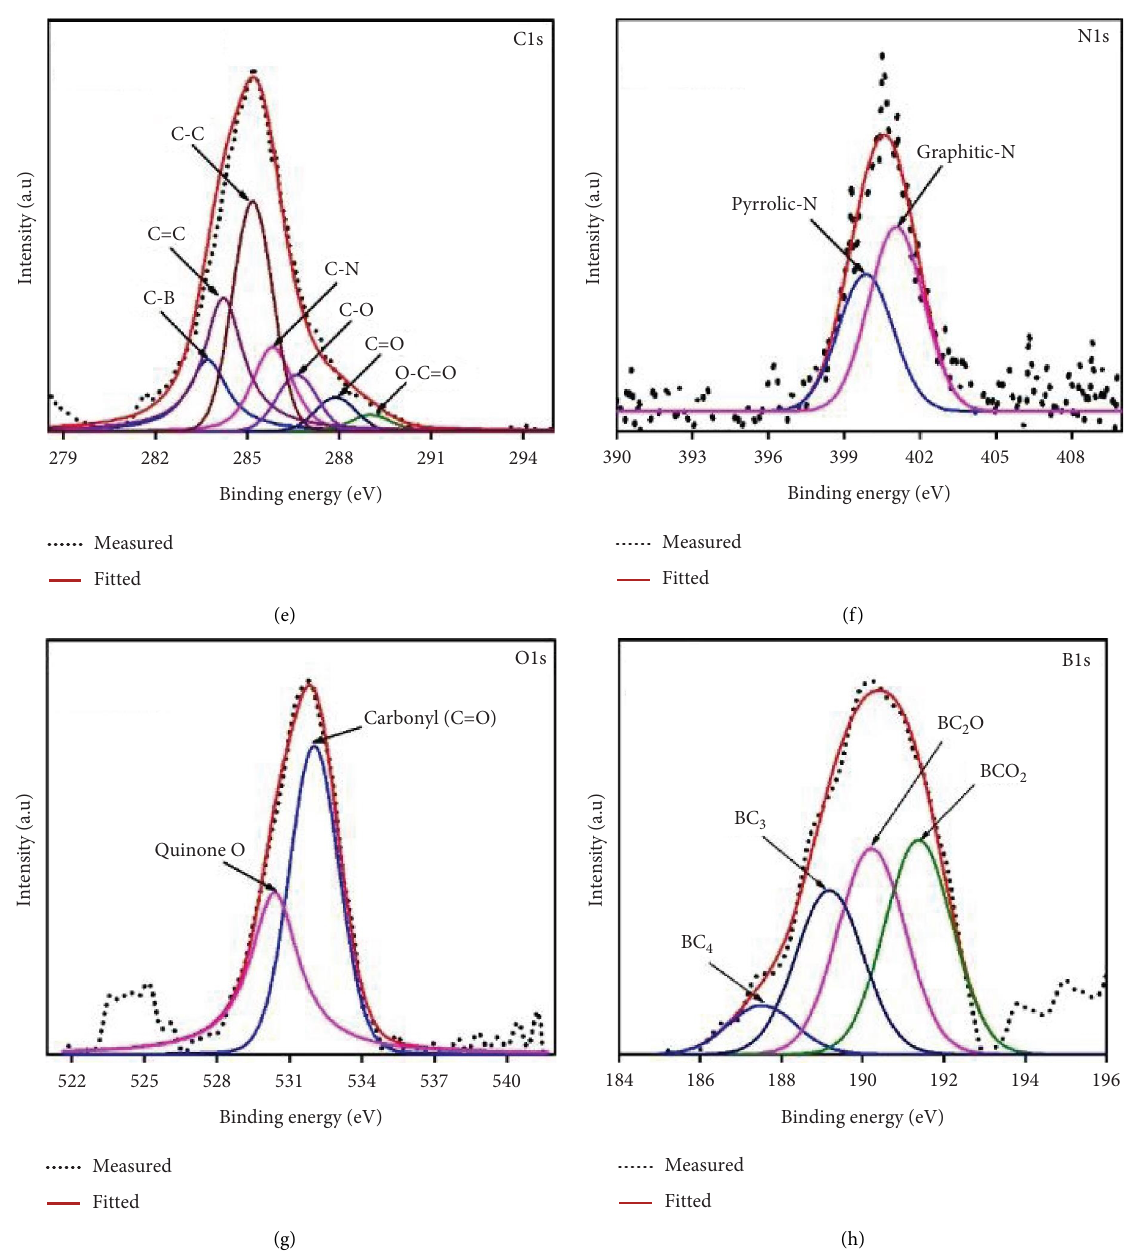
Figure 6: (a) Te XPS wide scan of GQDs and BGQDs (b–h) are C1s, N1s, O1s, and B1s of GQDs and BGQDs,